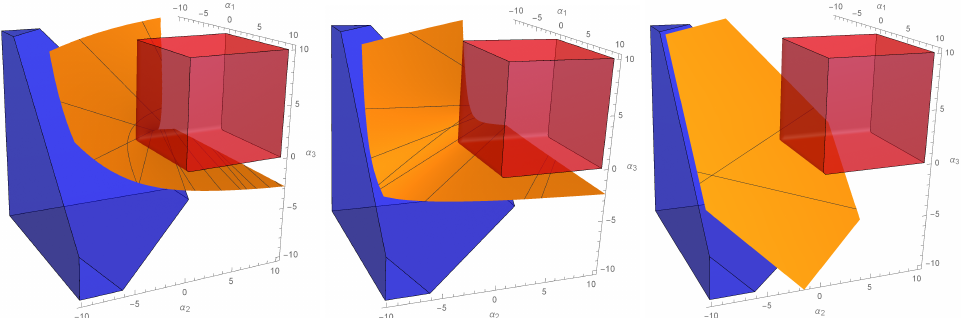
Figure 2. Parametric surfaces S ( β , q 1 , q 2 , q 3 , q ) (yellow) for β = 5 and several values of the fractional orders: q 1 = 0.4, q 2 = 0.8, q 3 = 1.5, q = 1.8 (left), q 1 = 0.2, q 2 = 0.3, q 3 = 1.2, q = 1.5 (centre) and q 1 = 0.7, q 2 = 0.71, q 3 = 0.72, q = 1.5 (right). The blue and red regions represent the fractional- order-independent instability and asymptotic stability regions, given by Lemma 1 and Lemma 2,